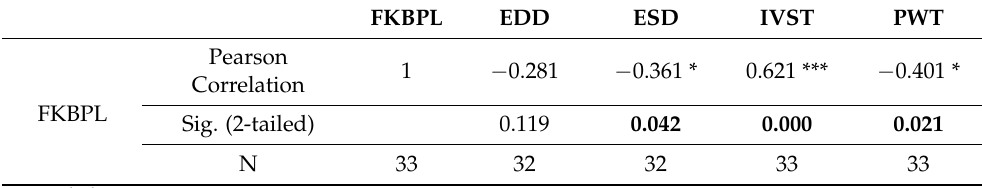
Table 2. Correlations between FKBPL and echocardiography parameters.